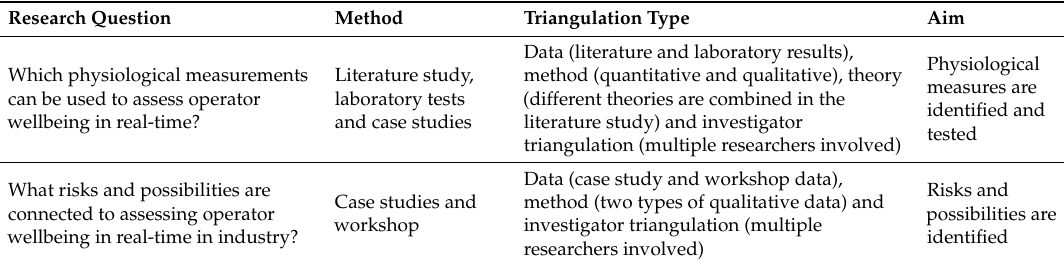
Table 1. Mixed method design used to answer research